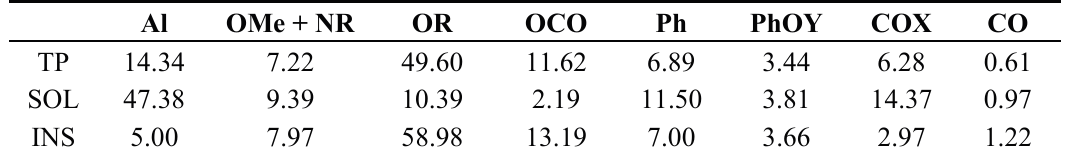
Table 2. C types and functional groups a distribution as mole % of total organic C for the tomato plant powder (TP), and the SOL and INS